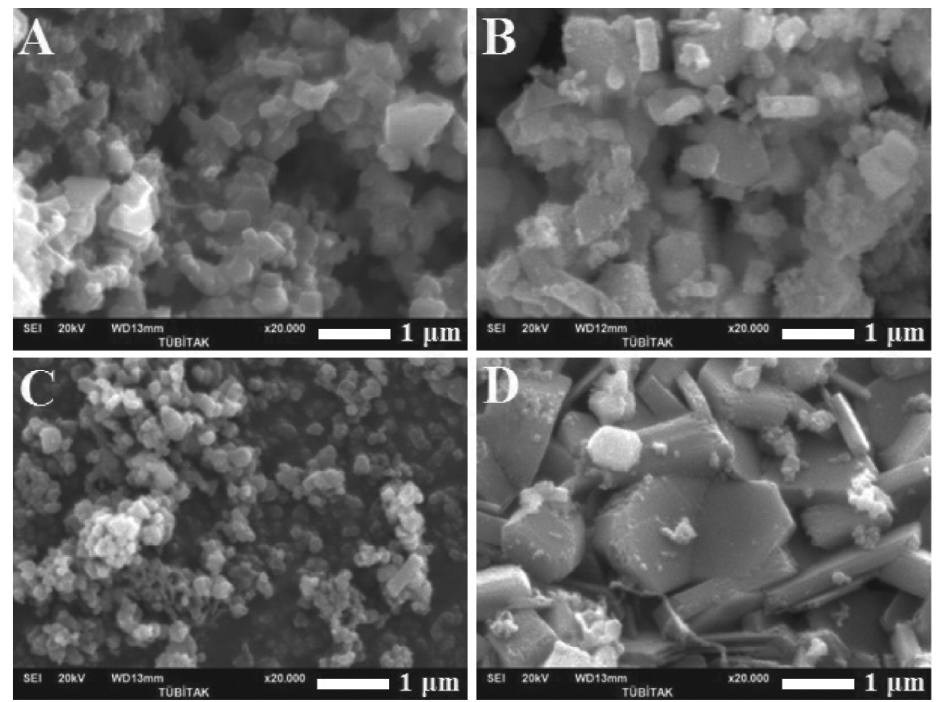
Fig. 8: SEM micrographs of self-propagating high temperature synthesized and leached TiB 2 powders. (A): Atmospheric conditions and 100% Mg; (B): Ar atmosphere and 100% Mg; (C): 2.5% NaCl addition, Ar atmosphere and 100% Mg; (D): 2.5% MgSO 4 ·7H 2 O addition, Ar atmosphere and 100%